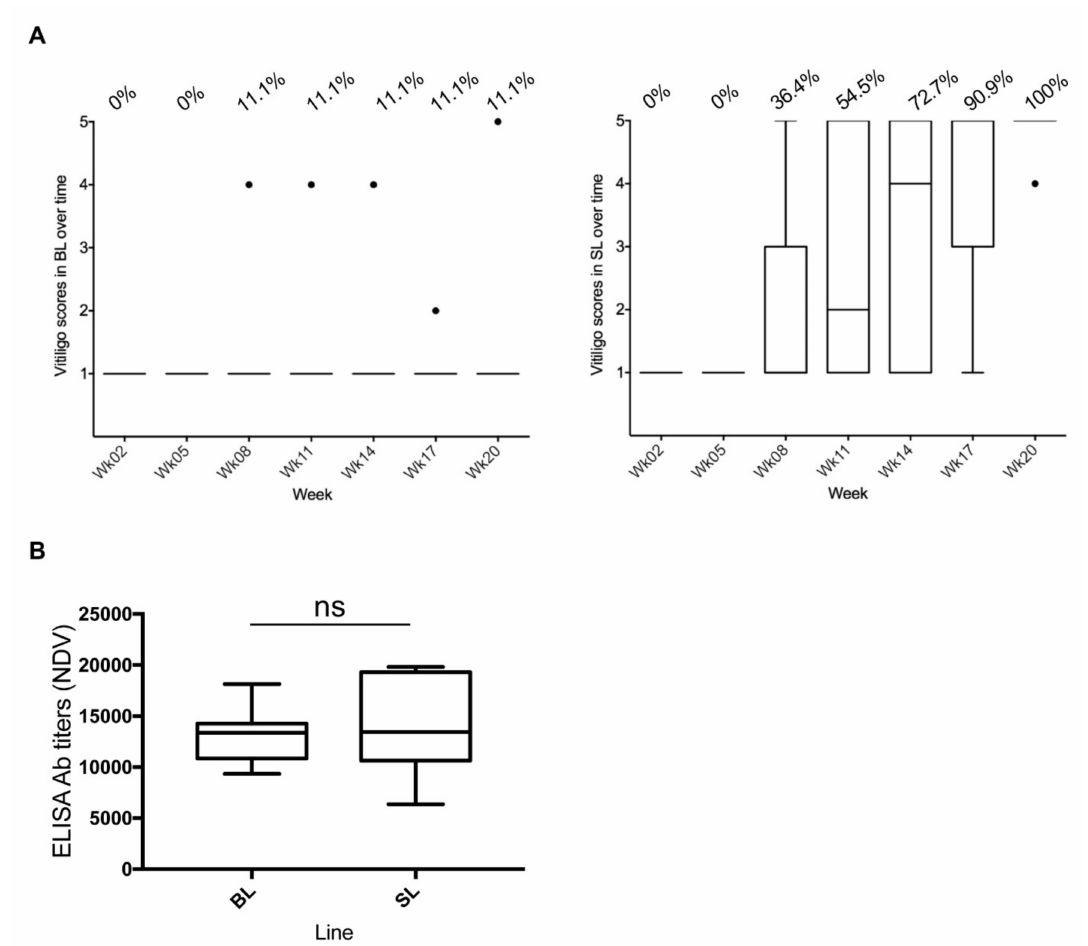
Figure 1. Herpes virus of turkey–Newcastle disease (HVT-ND) vaccination and vitiligo development in Smythlinechickens. AlldataareshowninTukeyboxeswithmediansashorizontalbarsandinterquartile ranges as vertical bars with notches. The black individual dots represent outliers. ( A ) Vitiligo score in Brown line (BL) and Smyth line (SL) chickens over time. A score of 1 corresponds to “no vitiligo” and a score of 5 to “complete vitiligo”. The percentage of birds having developed vitiligo is indicated above the graphs for each time. One hundred percent of SL chickens ( n = 11) had developed severe vitiligo at week 20, as did one of the BL chickens ( n = 9). ( B ) HVT-ND uptake. NDV antibody titers in plasma were measured at week 11 by ELISA. All birds had elevated titers, mostly above 10,000, indicating good vaccine uptake and antibody response. ns,